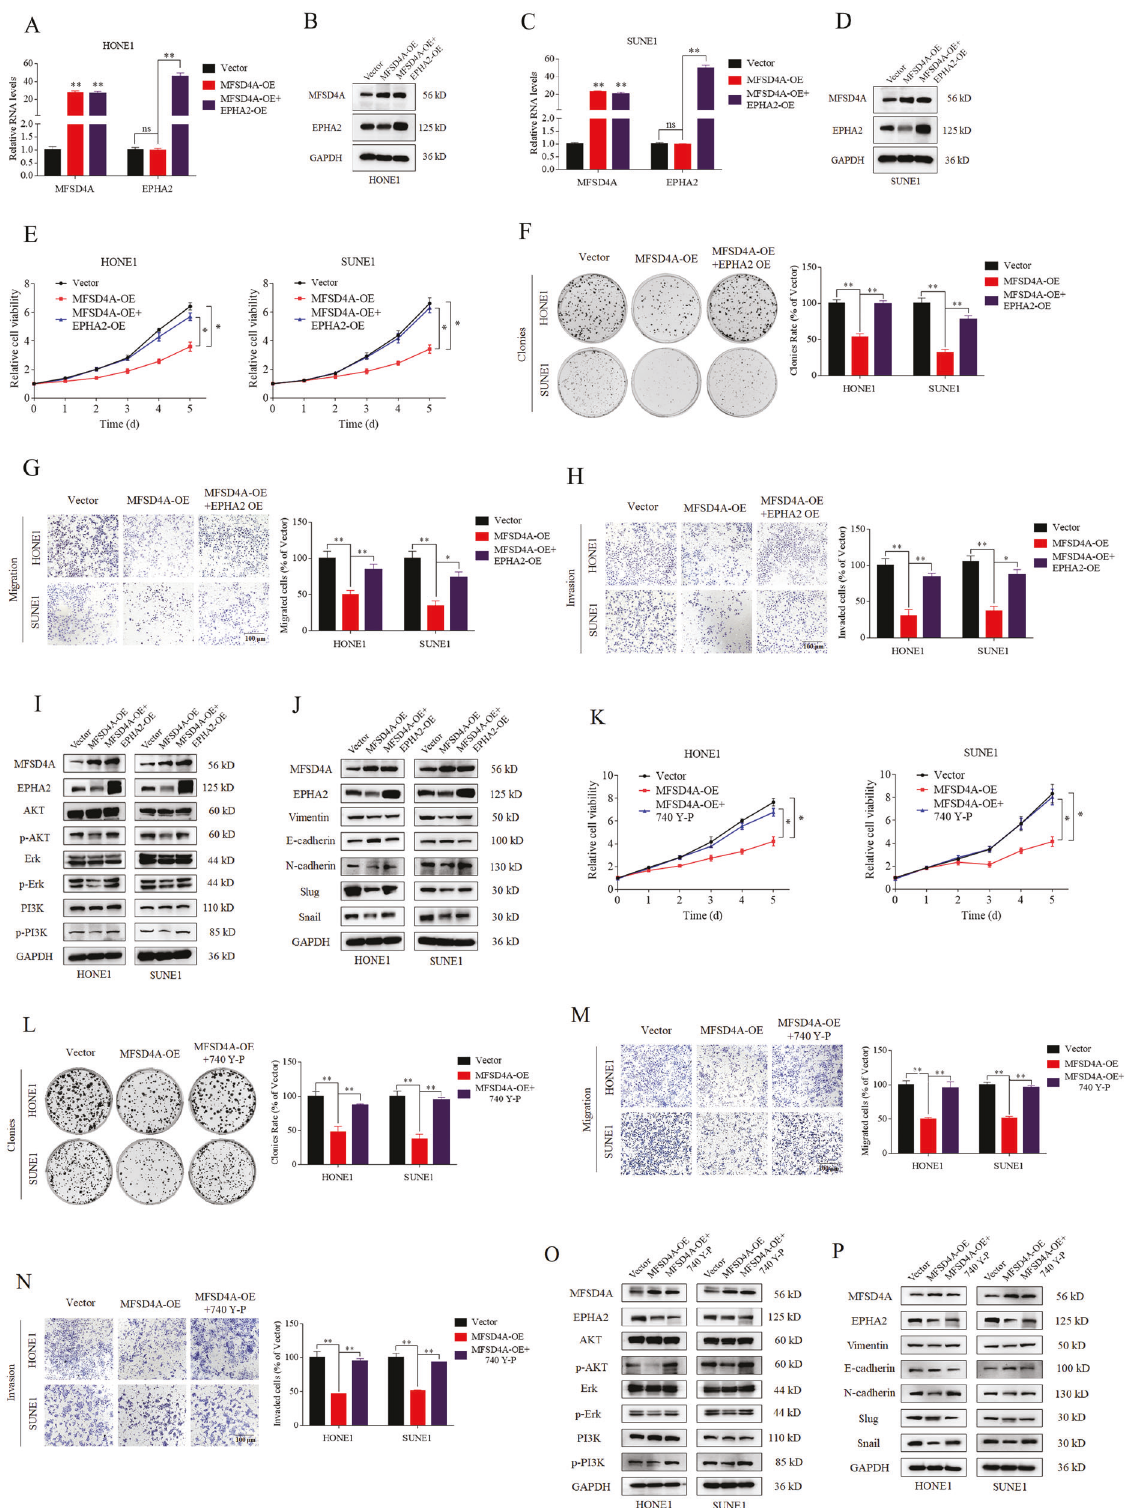
mechanism showed that overexpression of MFSD4A decreased EPHA2 levels, which was accompanied by changes in the PI3K- AKT-ERK1/2 pathway and EMT. EPHA2 has been reported to be associated with mitogen activated protein kinase (MAPK) path- ways. Jing-Hui et al. reported that overexpression of microRNA